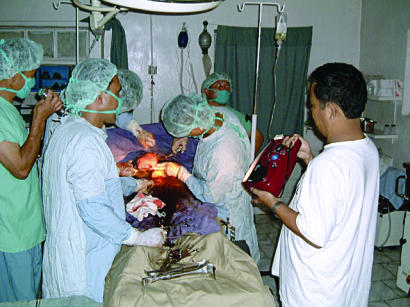
Operations at Okhaldhunga Hospital Being Carried Out without Electricity under Torchlight(Photo: Erik Bøhler)